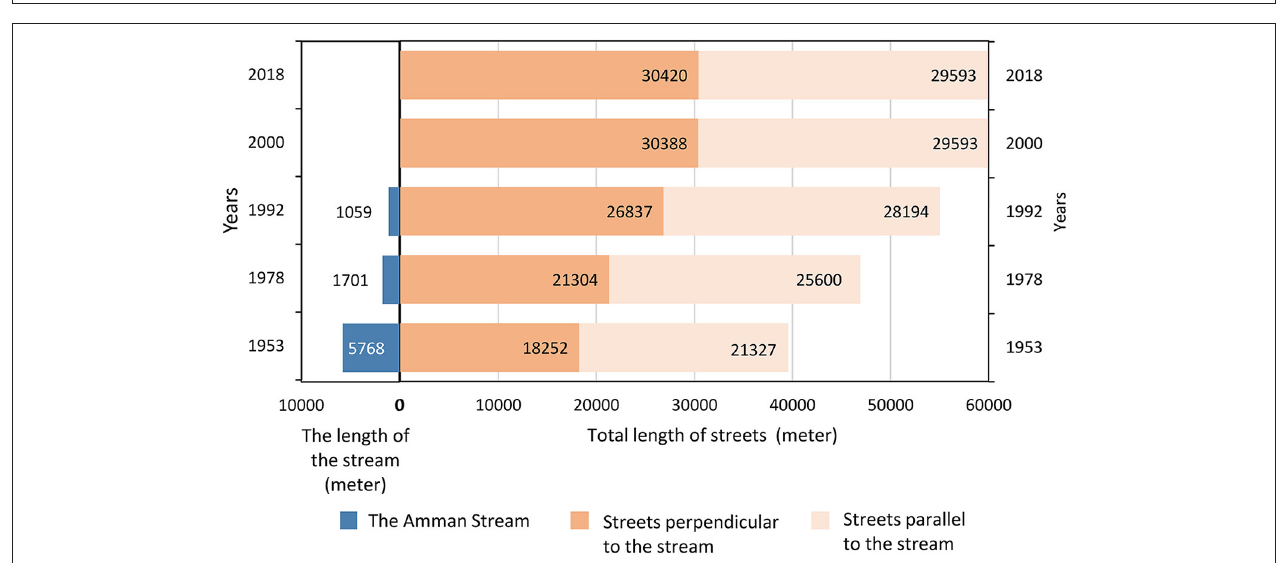
FIGURE 6 | Change over time of the total length of streets in a 150-m buffer on both sides of the Amman Stream.